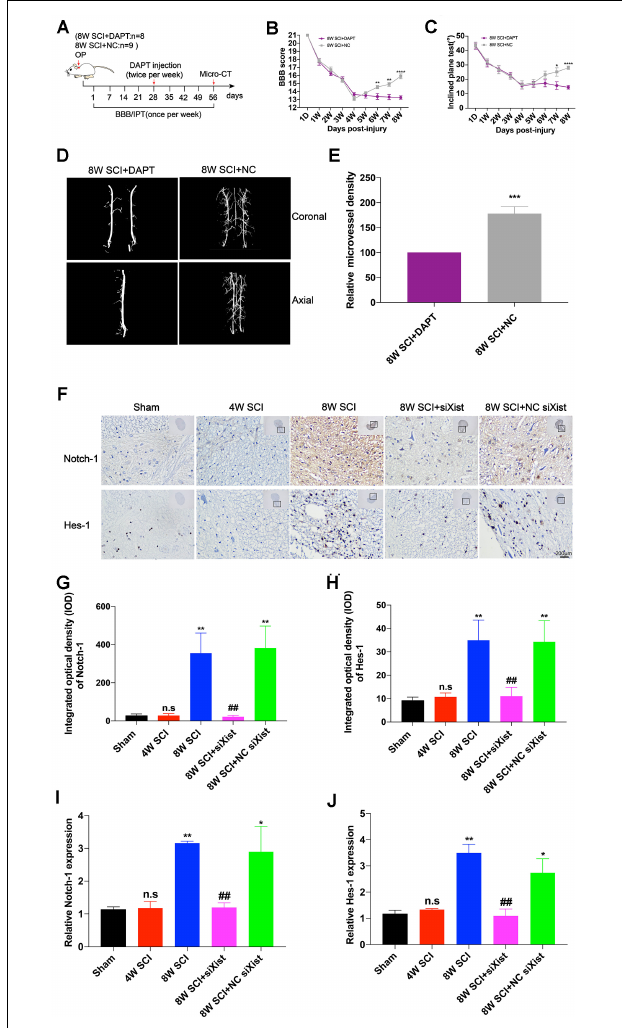
FIGURE 3 | Notch-1 promotes angiogenesis and endogenous neurological repair and causes downregulation of Notch-1 and Hes-1 after Xist depletion in CCSCI rats. (A) Experimental design. (B) Neurological function was evaluated using the BBB score. (C) Neurological function was evaluated using the IPT. (D) Three-dimensional reconstruction and representative micro-CT images of the microvessels of the cervical spinal cord. (E) Quantitation of the relative microvessel density. Data are expressed as the mean ± SEM. * p < 0.05, ** p < 0.01, **** p < 0.0001. (F) Notch-1 and Hes-1 expression was assessed by immunohistochemistry (20 × and 400 × magnification; scale bar, 200 µ m). Notch-1 and Hes-1 are mainly expressed in the lesion site of the cervical spinal cord. (G) Notch-1 immunohistochemical staining was quantitated by analyzing the integrated optical density (IOD). (H) Hes-1 immunohistochemical staining was quantitated by analyzing the integrated optical density (IOD). (I) The relative Notch-1 expression was assessed by RT-qPCR. (J) The relative Hes-1 expression was assessed by RT-qPCR. (G–J) ns (non-significant) as compared with the sham group; * p < 0.05, ** p < 0.01 as compared with the 4W SCI group; ## p < 0.01 as compared with the 8W SCI group. All data are expressed as the mean ± SEM. * p < 0.05, ** p < 0.01, *** p < 0.001, **** p < 0.0001 as compared with 8W SCI + DAPT group.